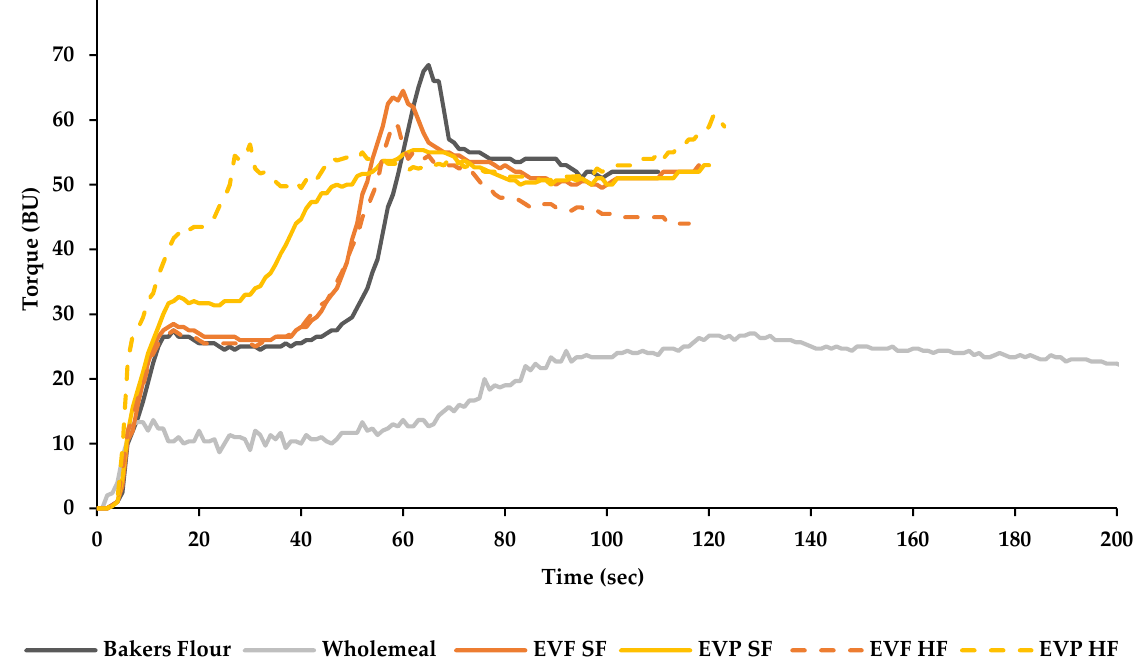
Figure 3. Gluten network development of baker’s flour formulation enriched with EverVita ingredients (EverVita FIBRA (EVF), EverVita PRO (EVP)) at two inclusion levels (source of fibre (SF), high in fibre (HF)) compared to baker’s flour control and wholemeal flour control. The curves represent average torque values of triplicates per sample. Fibre fortification using EverVita ingredients influenced the starch pasting properties as demonstrated in Table 2. Chosen decisive parameters are peak viscosity, breakdown viscosity, trough viscosity and final viscosity. The peak viscosity represents the maximum viscosity during heating and shearing and refers to the water binding capacity and swelling power of the starch. C1 showed the highest peak viscosity (1209 ± 9 cP) among the samples, while C2 showed the lowest (599 ± 33 cP). The incorporation of EverVita ingredients led to a significant lower degree of swelling compared to C1. This effect was advanced by HF addition levels of EVF (865 ± 2 cP) and EVP (812 ± 4 cP). After the peak viscosity, amylose and amylopectin leach out of the starch granules causing a decrease in viscosity to a certain trough. The trough viscosity indicates the holding strength of the system before retrogradation occurs.